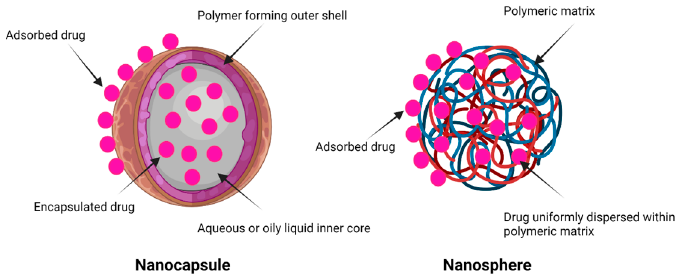
Figure 2. Morphological difference between the nanospheres and nanocapsules. Created with Bio- Render.com (accessed on 4 February 2023). BioRender.com (accessed on 4 February